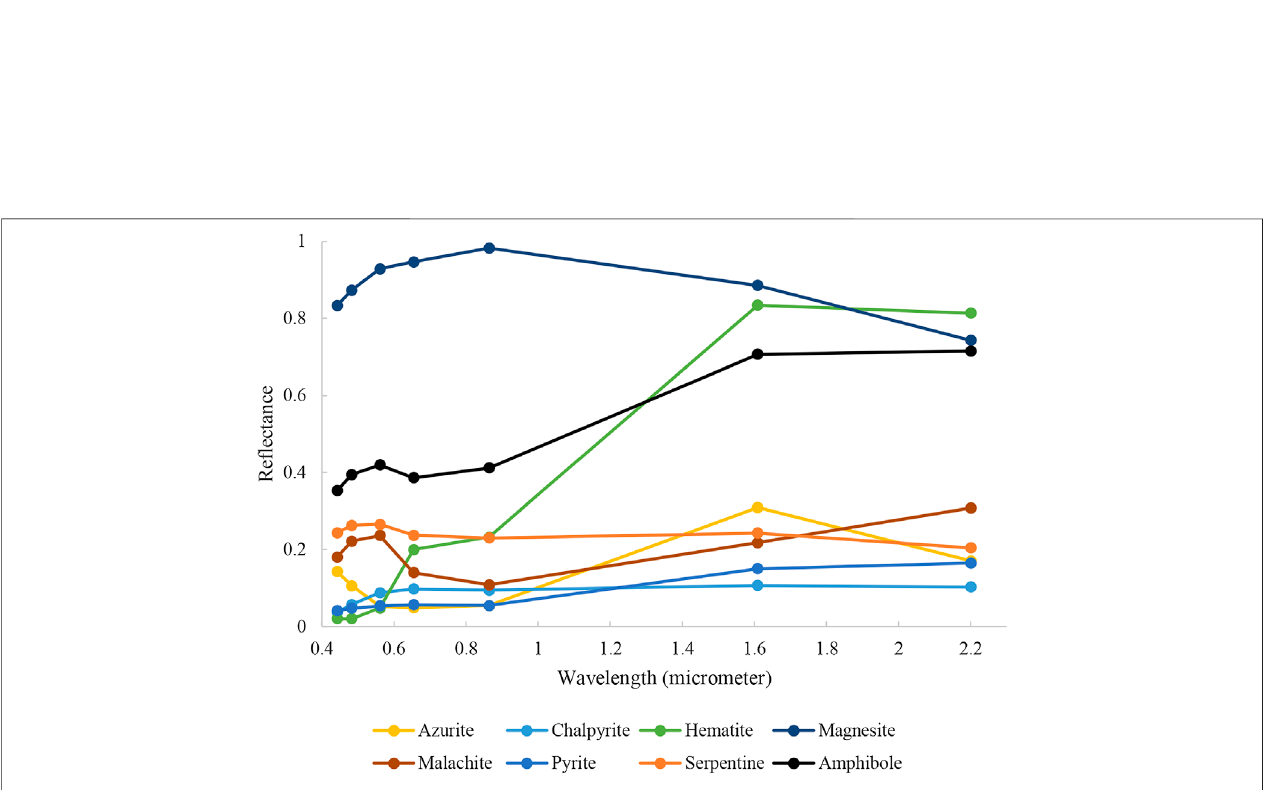
FIGURE 18 | Spectral plot of convolved laboratory measured spectrum of selected minerals.